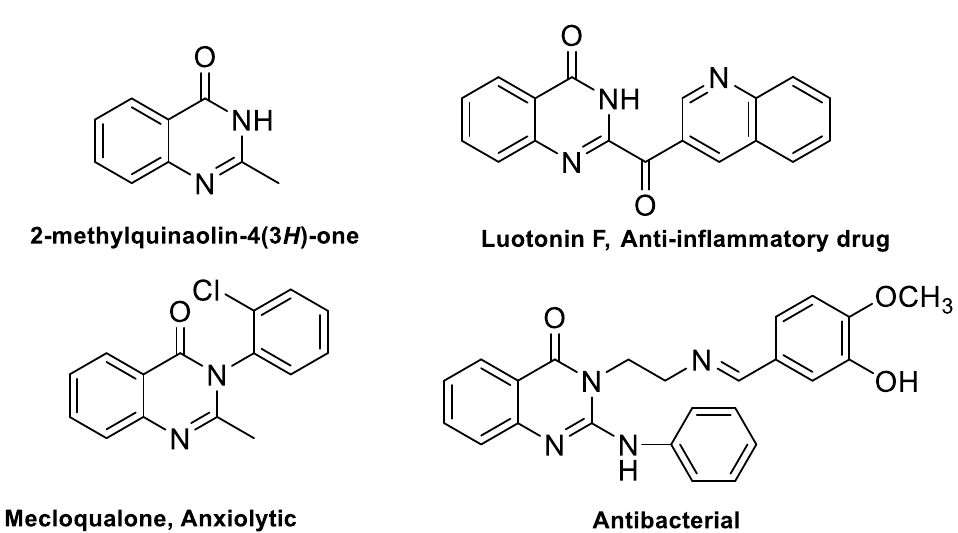
Figure 1. Selected examples of bio-active drugs with a quinazolinone skeleton.